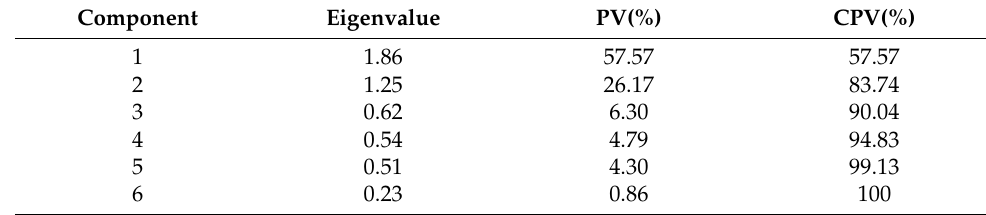
Figure 4. Principal component analysis (PCA) of soil nitrogen and environmental variables for various grassland types. Note: PS: Pontic Steppe; MES: Middle East Steppe; KS: Kazakh Steppe; KSD: Kazakh Semi-Desert Steppe; KFS: Kazakh Forest Steppe; MAT: mean annual temperature; MAP: mean annual precipitation; Srad: solar radiation; pH: soil pH; NDVI: Normalized Difference Vegetation Index. Table 3. Decomposition of total variance for principal component